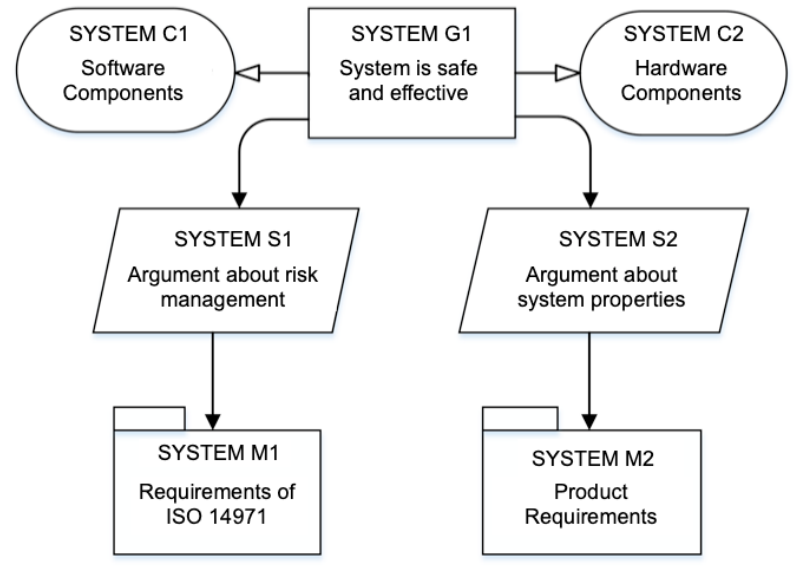
Figure 4. Top level GSN assurance case of insulin infusion pump